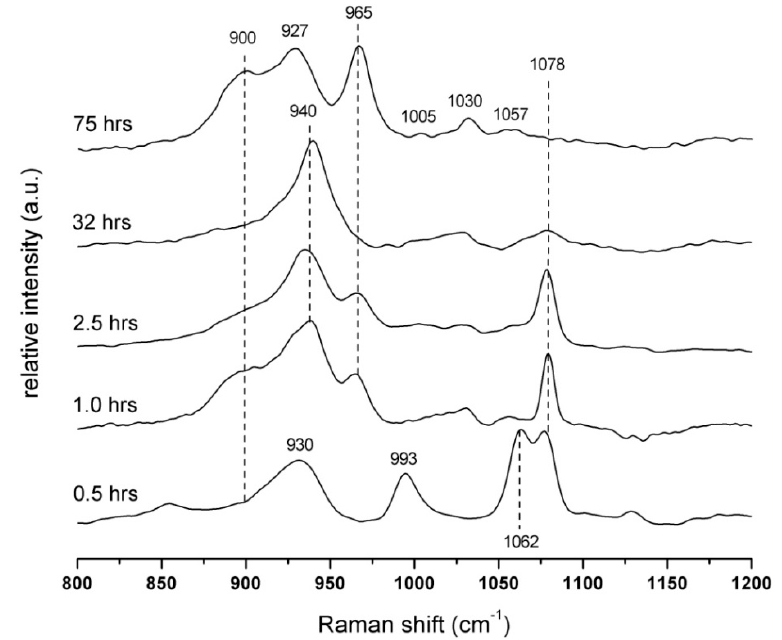
Figure 4. Raman spectra of alkali-activated BFS with Na 3 PO 4 recalculated to the 2.5 wt % addition of P 2 O 5 .